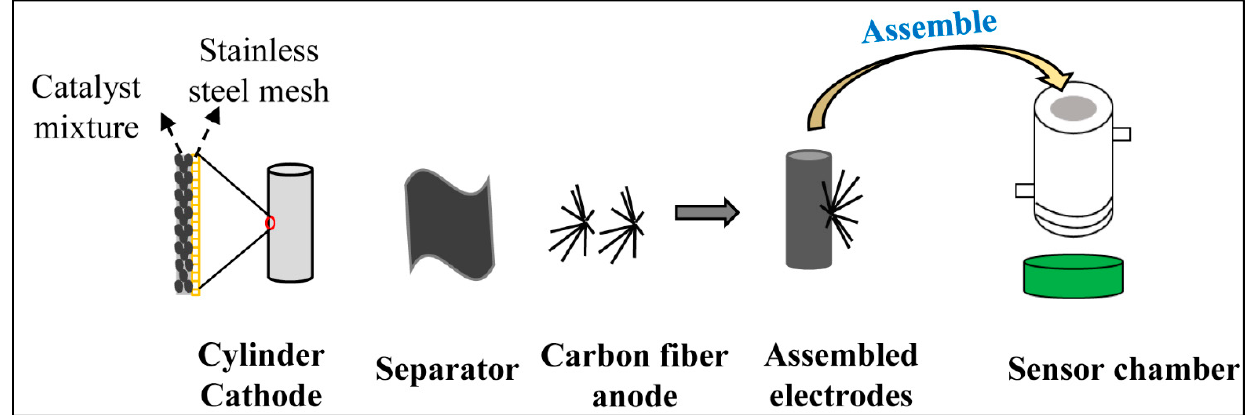
Figure 1. A diagram showing the CS production process.